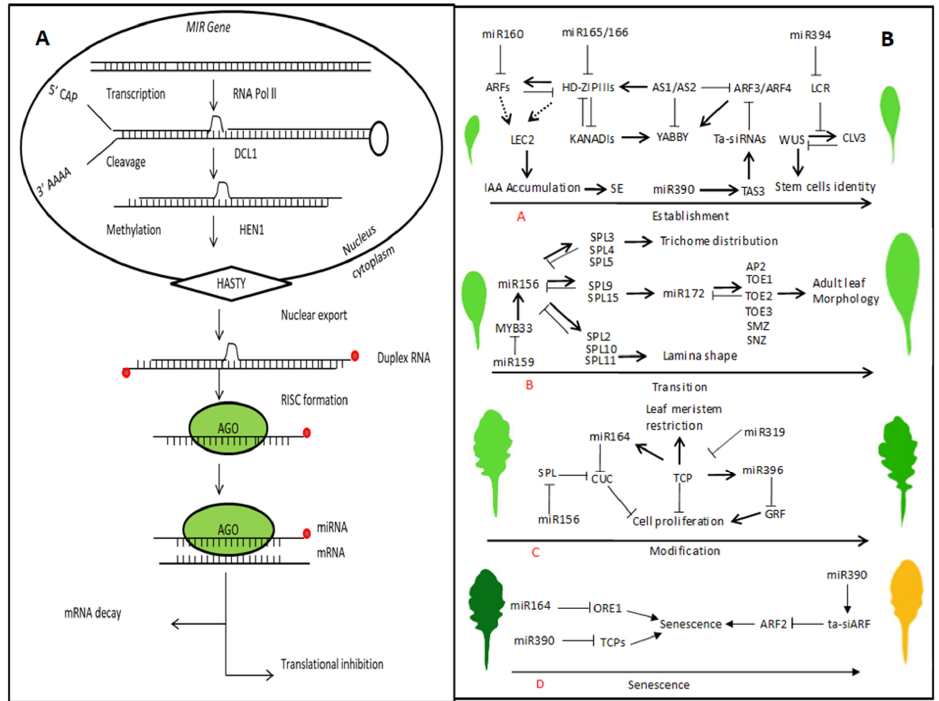
Figure 4. A schematic pathway for miRNA biosynthesis and the degradation of target mRNA. ( A ) Primary miRNAs are formed by polymerase II that folds back to form a hairpin structure.